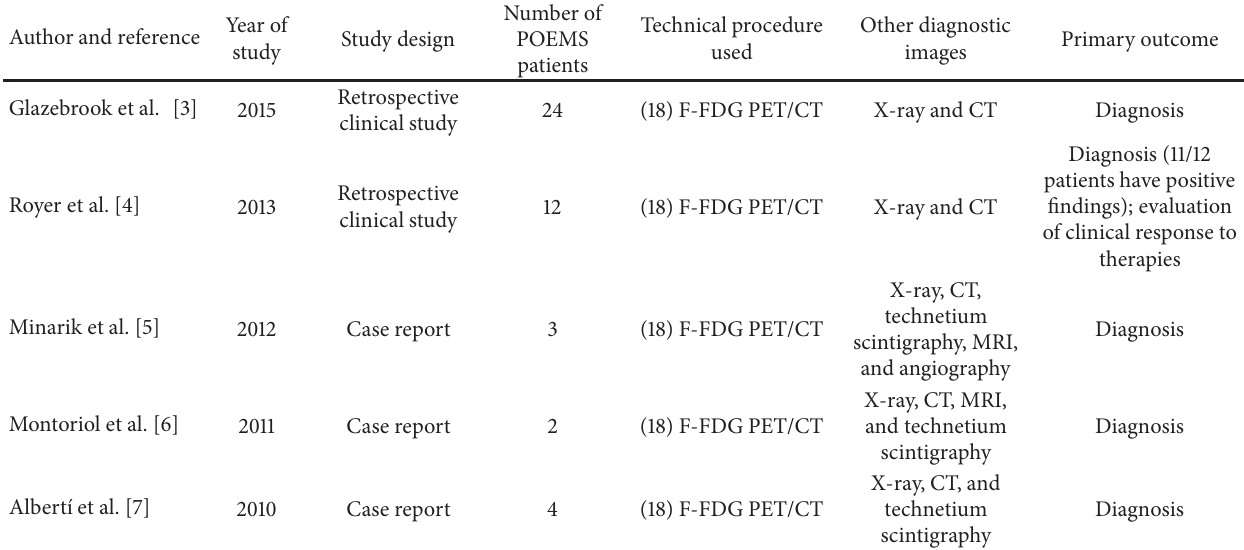
Table 2: Clinical characteristics of POEMS cases in published